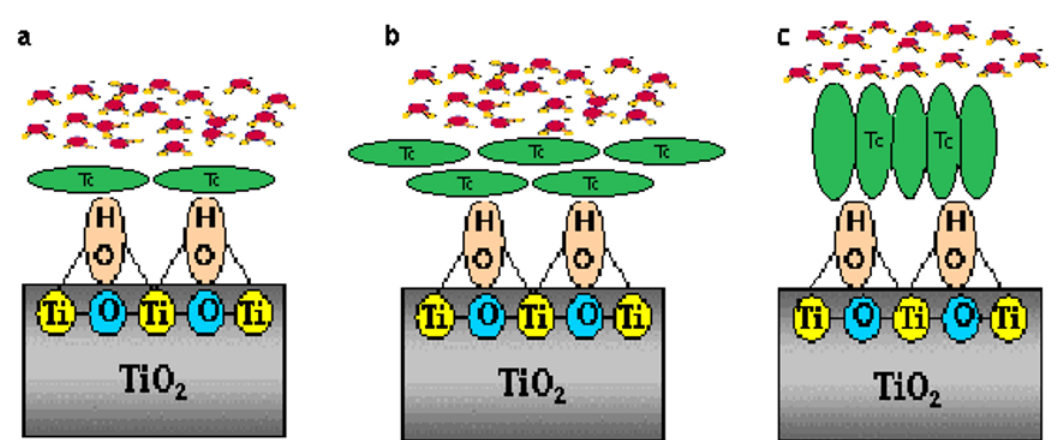
Figure 13. Scheme of the kind of adsorption of tetracycline from water on the surface of titania, (a) monolayer, (b) layer-by-layer and (c) vertically assembled.